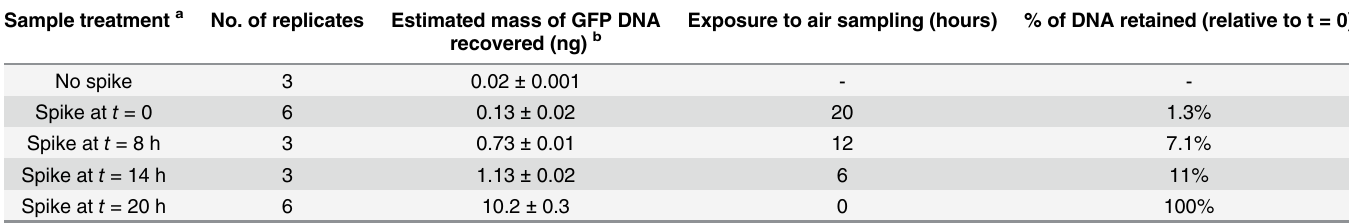
Table 2. qPCR results from a series of 20-h samples illustrating the decay of GFP-tagged Shewanella oneidensis cells. Sample treatment